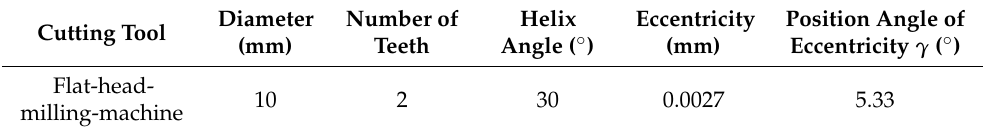
Table 4. Cutter’s parameters and measured results of the tool